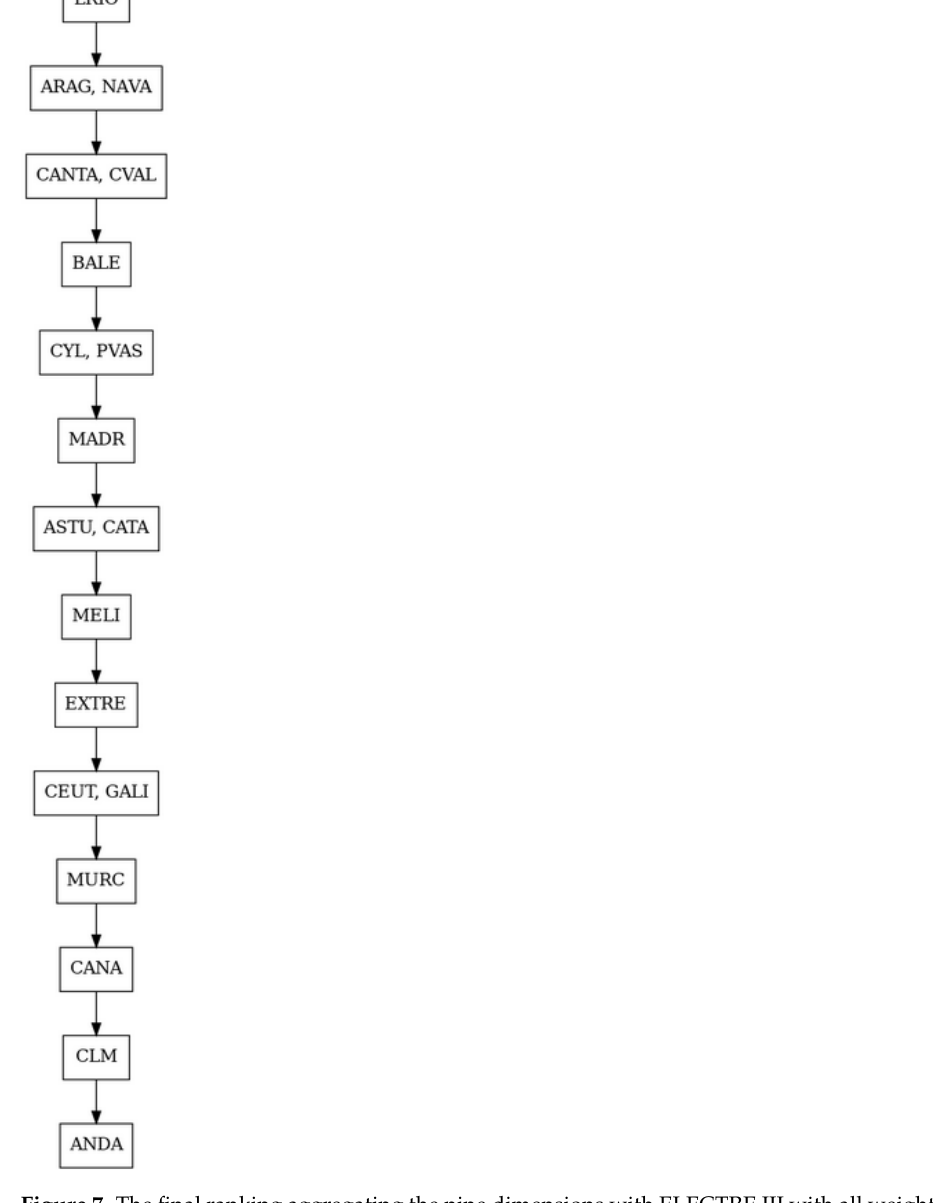
Figure 7. The final ranking aggregating the nine dimensions with ELECTRE III with all weights equal to 1 and no thresholds.